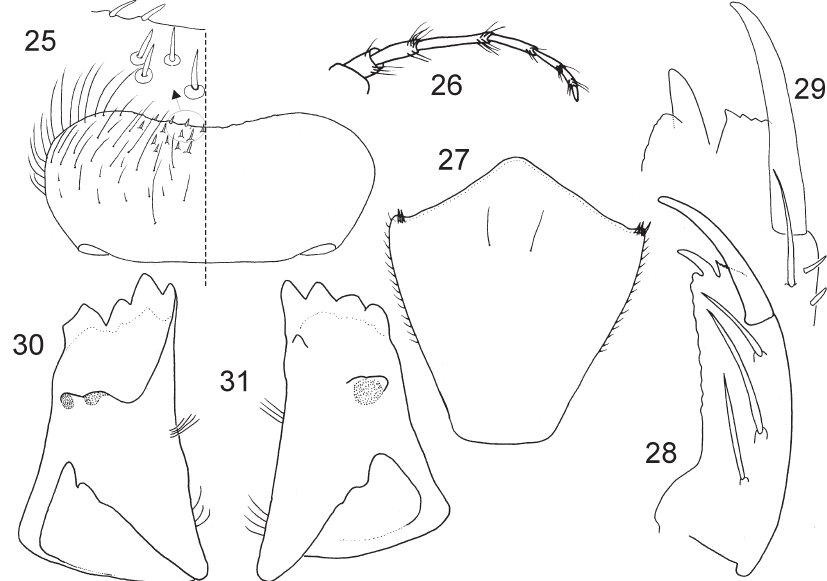
Figures 25-31 - Neoneura confundens , last instar larva: 25 , labrum with detail of setae at anteromedian emargination (setae omitted on right half), dorsal view; 26 , antenna; 27 , prementum, dorsal view; 28 , labial palp, dorsal view; 29 , detail of labial palp, dorsal view; 30 , left mandible, oclusal view; 31 , right mandible, oclusal